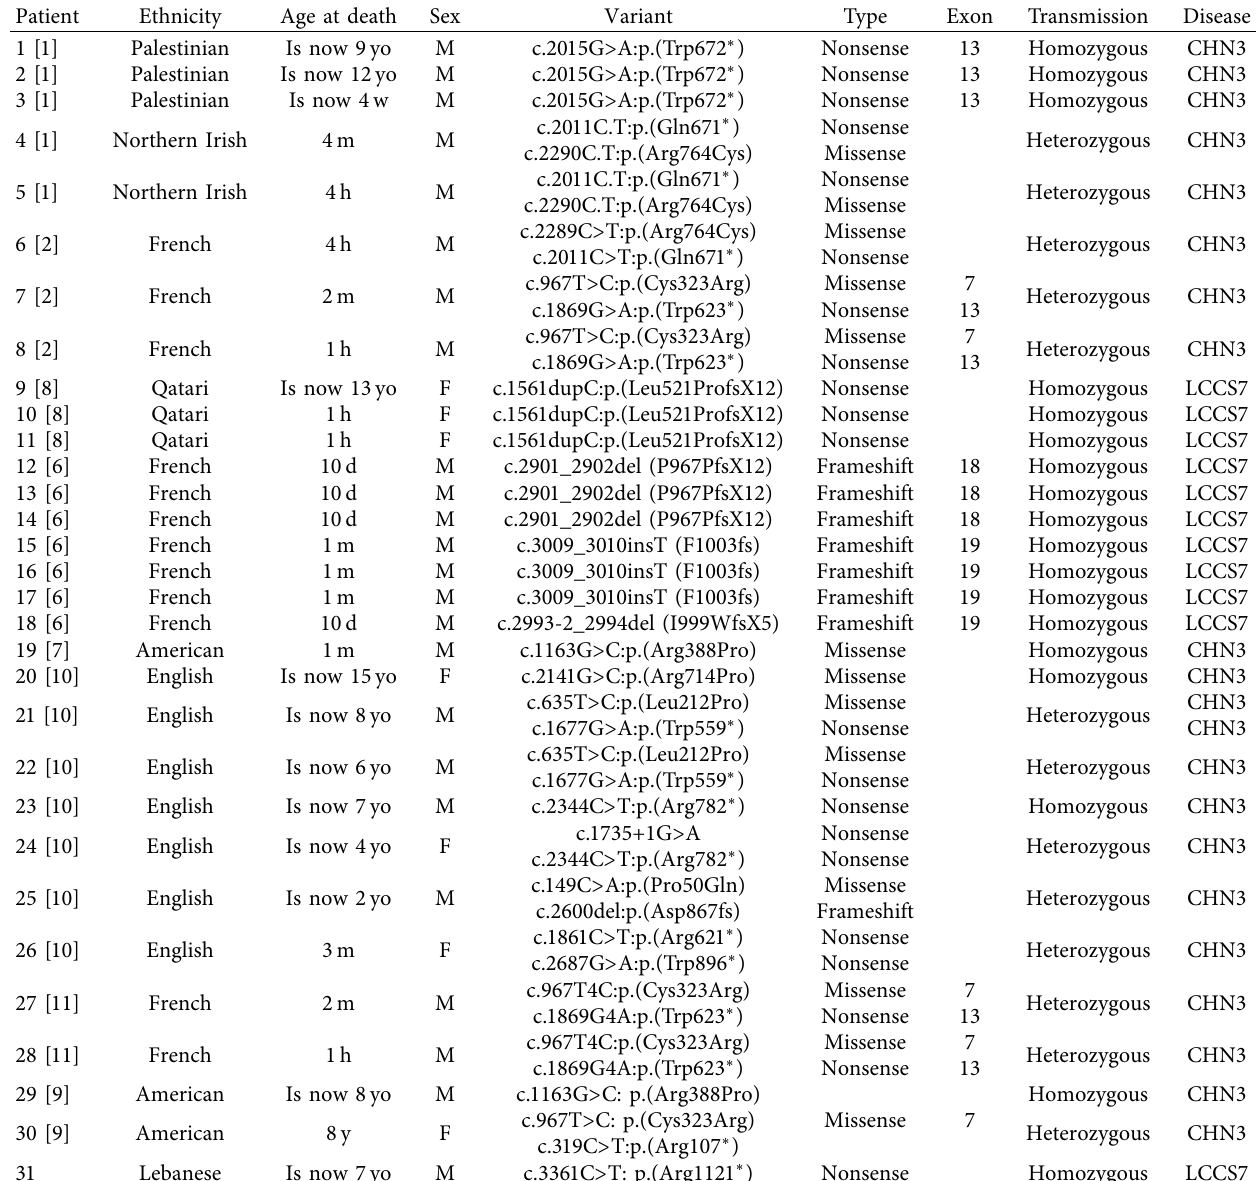
Table 2: Variants in CNTNAP1